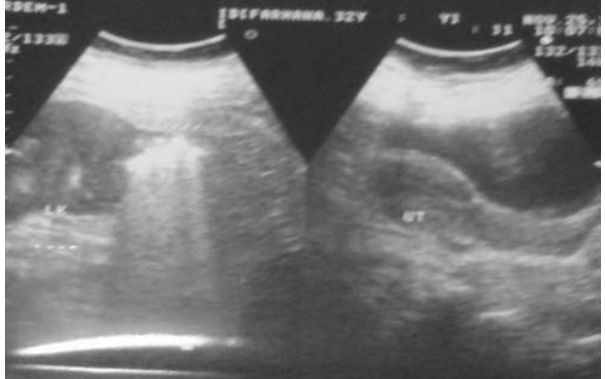
Fig 2. Chest X-ray (postero-anterior view) showing elevated left hemidiaphragm